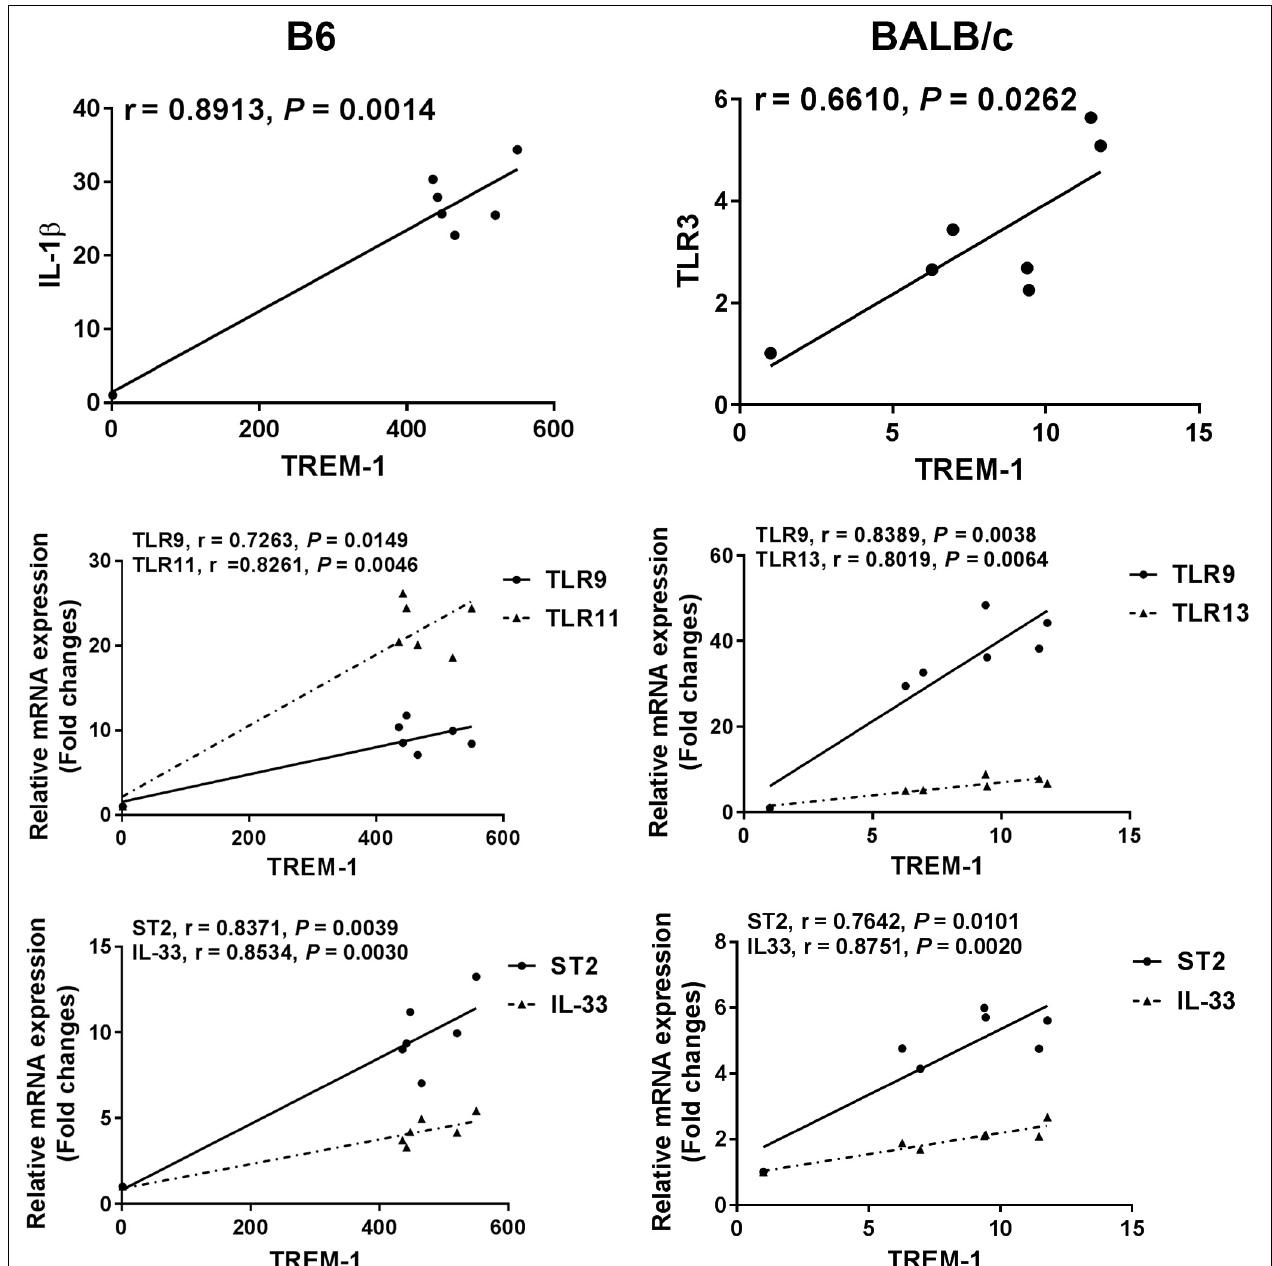
FIGURE 6 | Correlation analysis between the mRNA expressions of TREM-1 and IL-1 β , IL-33, ST2, or TLRs in the eyes of T. gondii -infected B6 and BALB/c mice. The r value generates the theoretical line of best fit, and the P value indicates the significance of the correlation. There were six mice in each group and the data represents from two